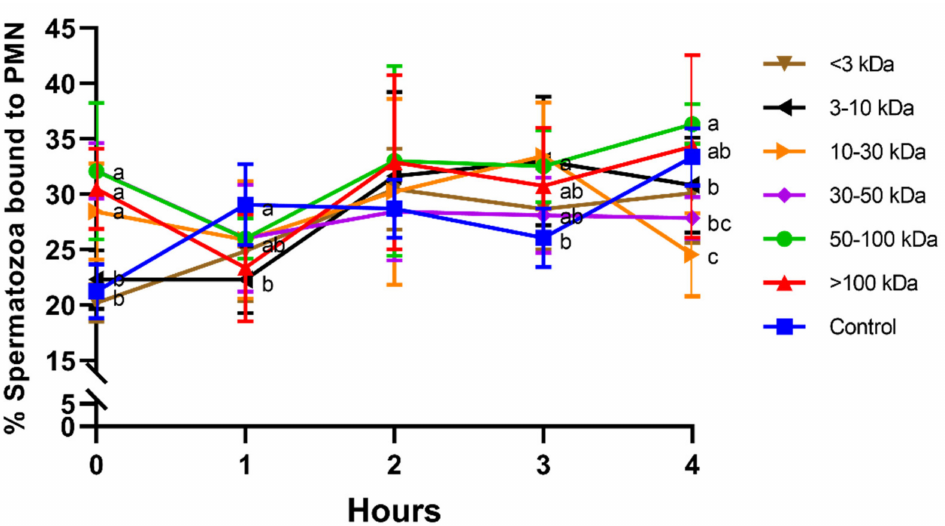
Figure 1. Percentages of spermatozoa bound to PMN for different seminal plasma fractions and throughout incubation at 38 ◦ C for 4 h. Different superscripts (a–c) mean significant differences between seminal plasma fractions within a given time point ( p ≤ 0.05). Data are shown as mean ± SD for 12 independent experiments.